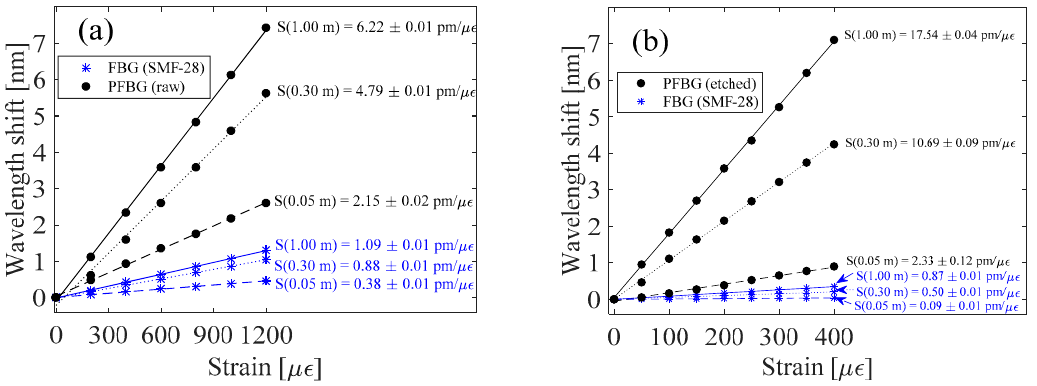
Figure 3. Sensitivity results of the silica and polymer FBGs, considering 2.7 cm mPOF and gauge lengths of 0.05, 0.30 and 1.00 m, for the sensing head with: ( a ) raw and ( b ) etched mPOF. Linear fits, adjusted to the experimental Bragg wavelength shifts with three gauge lengths (i.e., 1.00; 0.30; and 0.05 m), for the raw and etched mPOF sensing heads are presented in Figure 3a,b,